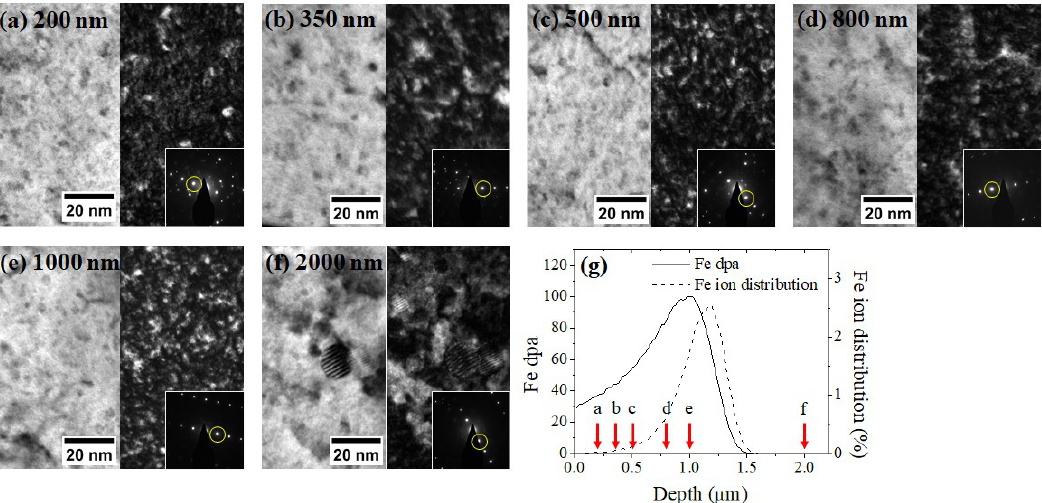
Figure 5. TEM bright-field and dark-field images of a Fe irradiated sample, taken from depths of ( a ) 200, ( b ) 350, ( c ) 500, ( d ) 800, ( e ) 1000, and ( f ) 2000 nm. Diffraction patterns obtained from the same grain are superimposed on each DF image with g110 marked by a yellow circle. ( g ) SRIM Fe damage profile is shown with red arrows indicating the depths of characterization. The dispersoid size decreased and the density increased within the ion range.